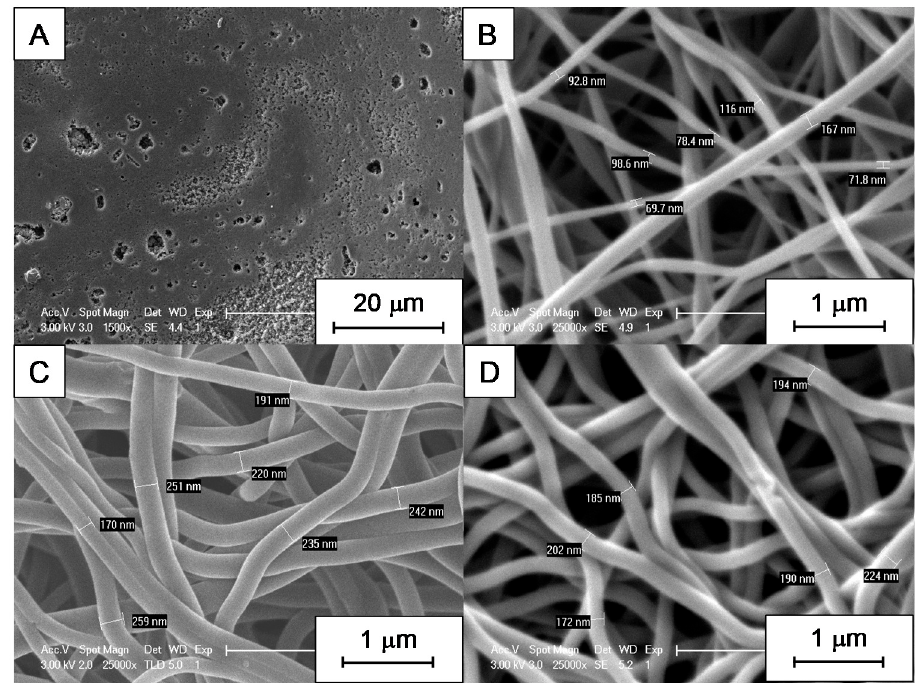
Figure 2. Scanning electron microscopy (SEM) micrographs of materials obtained from: ( A ) EOL; ( B ) PL; ( C ) KL and ( D ) Ketjen black added to KL. Voltage for electrospinning was 9 kV in all cases.